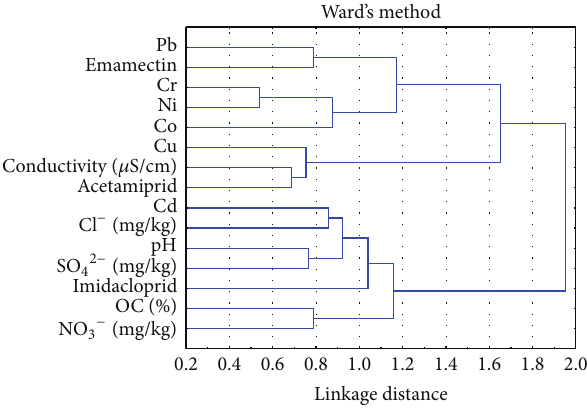
Figure 3: Cluster analysis for the determination of various parame-